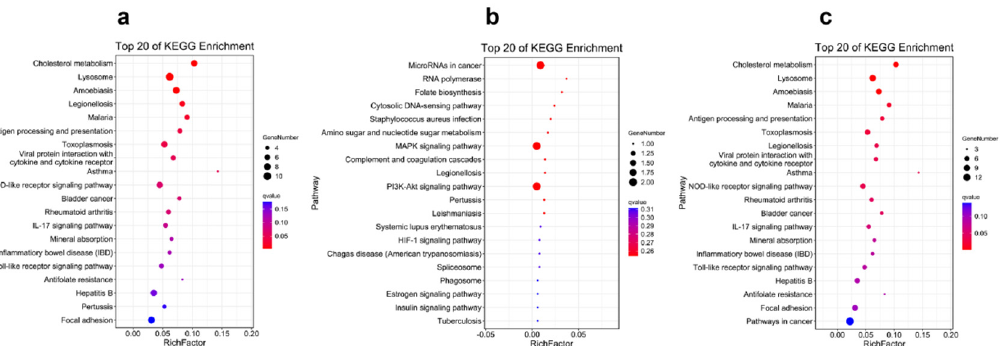
Figure 5. The Top 20 KEGG Pathways Enriched by the Differentially Expressed Genes in the Spleen at 12 h Postinjection: ( a ) the Top 20 Enrichment Pathways among All Differentially Expressed Genes; ( b ) the Top 20 Enrichment Pathways among the Upregulated Differentially Expressed Genes; ( c ) the Top 20 Enrichment Pathways among the Downregulated Differentially Expressed Genes.